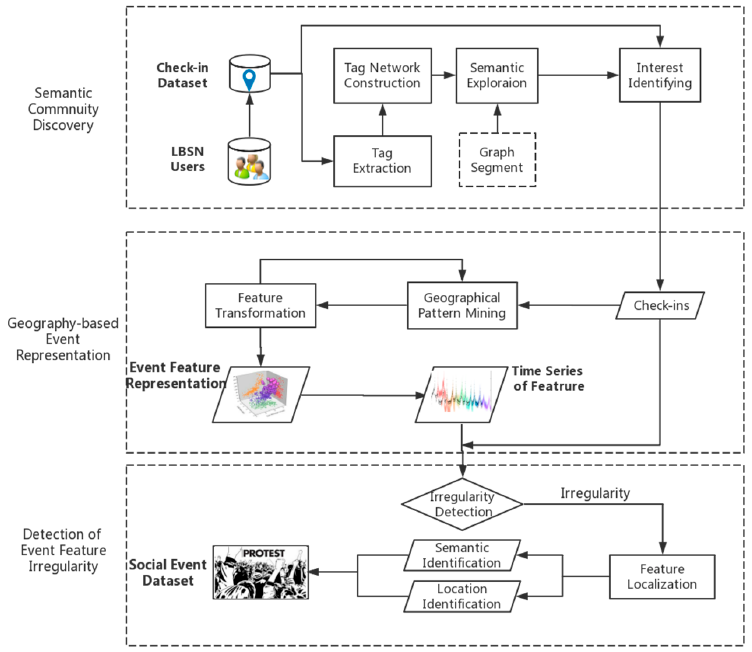
Figure 1. Proposed analytic workflow.